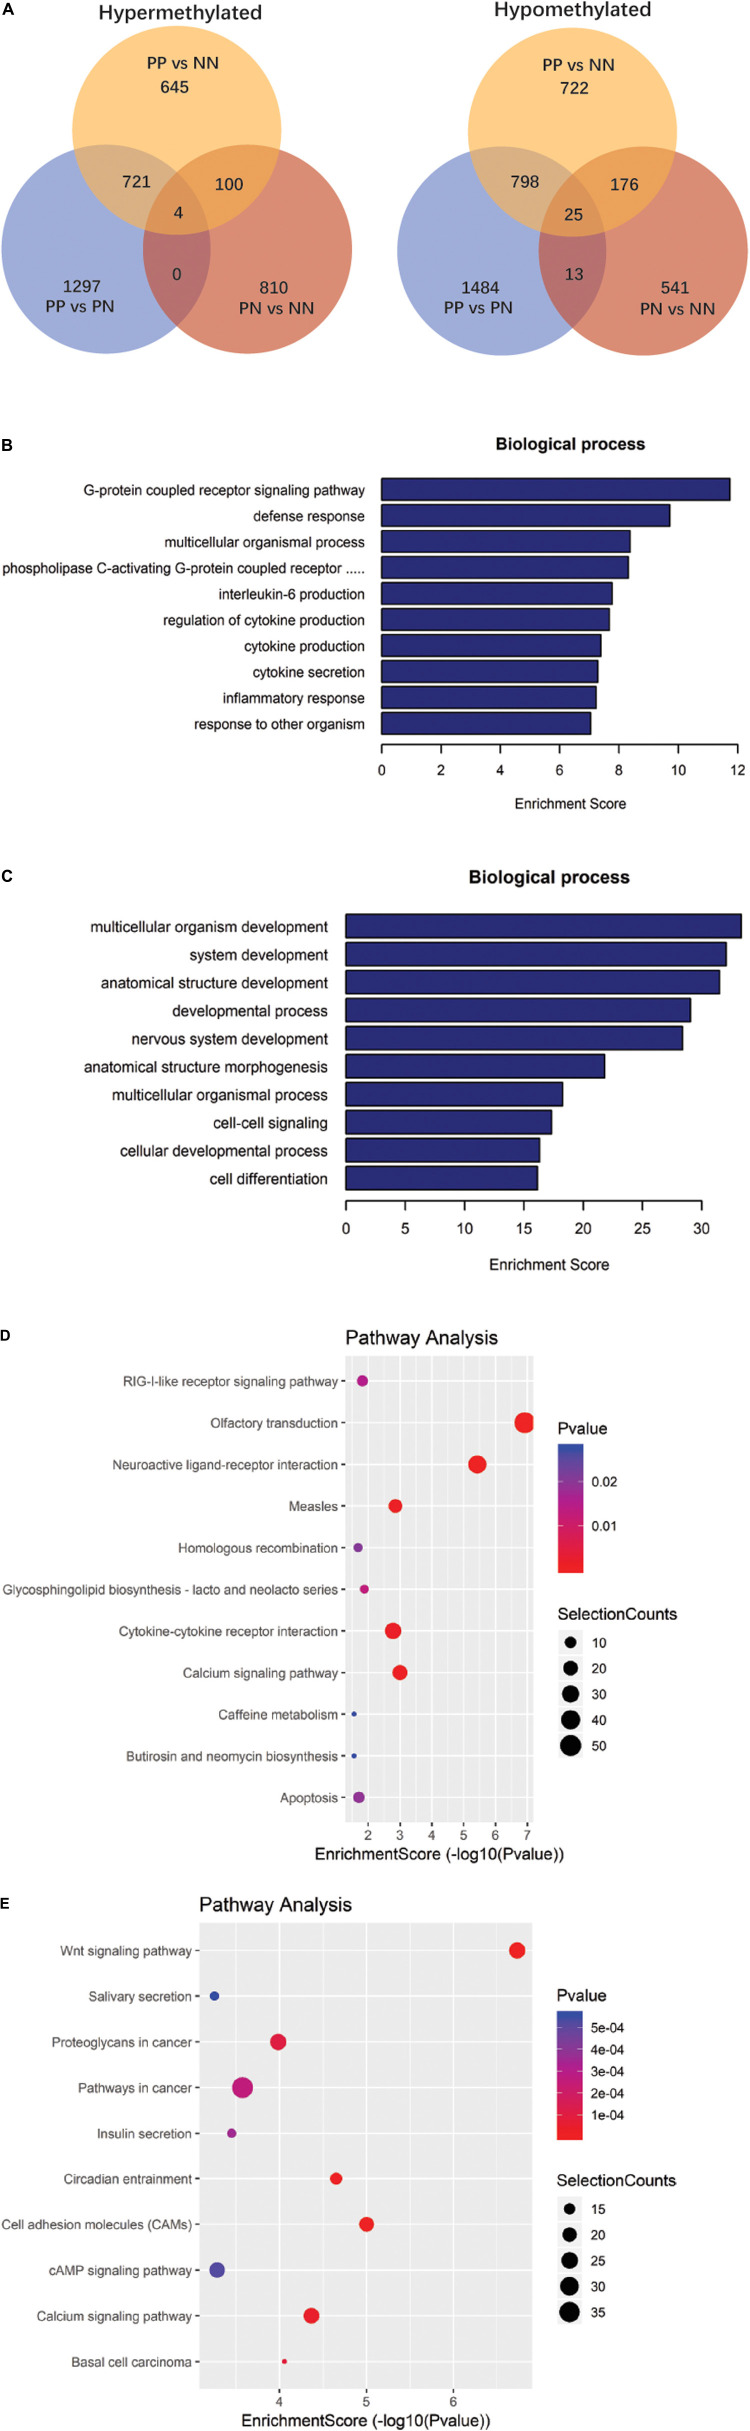
Gene ontology and Kyoto Encyclopedia of Genes and Genomes analyses of coding genes containing altered m6A peaks. (A) Comparison of the number of hypermethylated and hypomethylated m6A peaks identified in PP, PN, and NN samples. (B) The top 10 gene ontology terms were significantly enriched for the hypermethylated genes in PP vs. NN. (C) The top 10 gene ontology terms were significantly enriched for the hypomethylated genes in PP vs. NN. (D) The top 10 significantly enriched pathways for the hypermethylated genes in PP vs. NN. (E) The top 10 significantly enriched pathways for the hypomethylated genes in PP vs. NN.